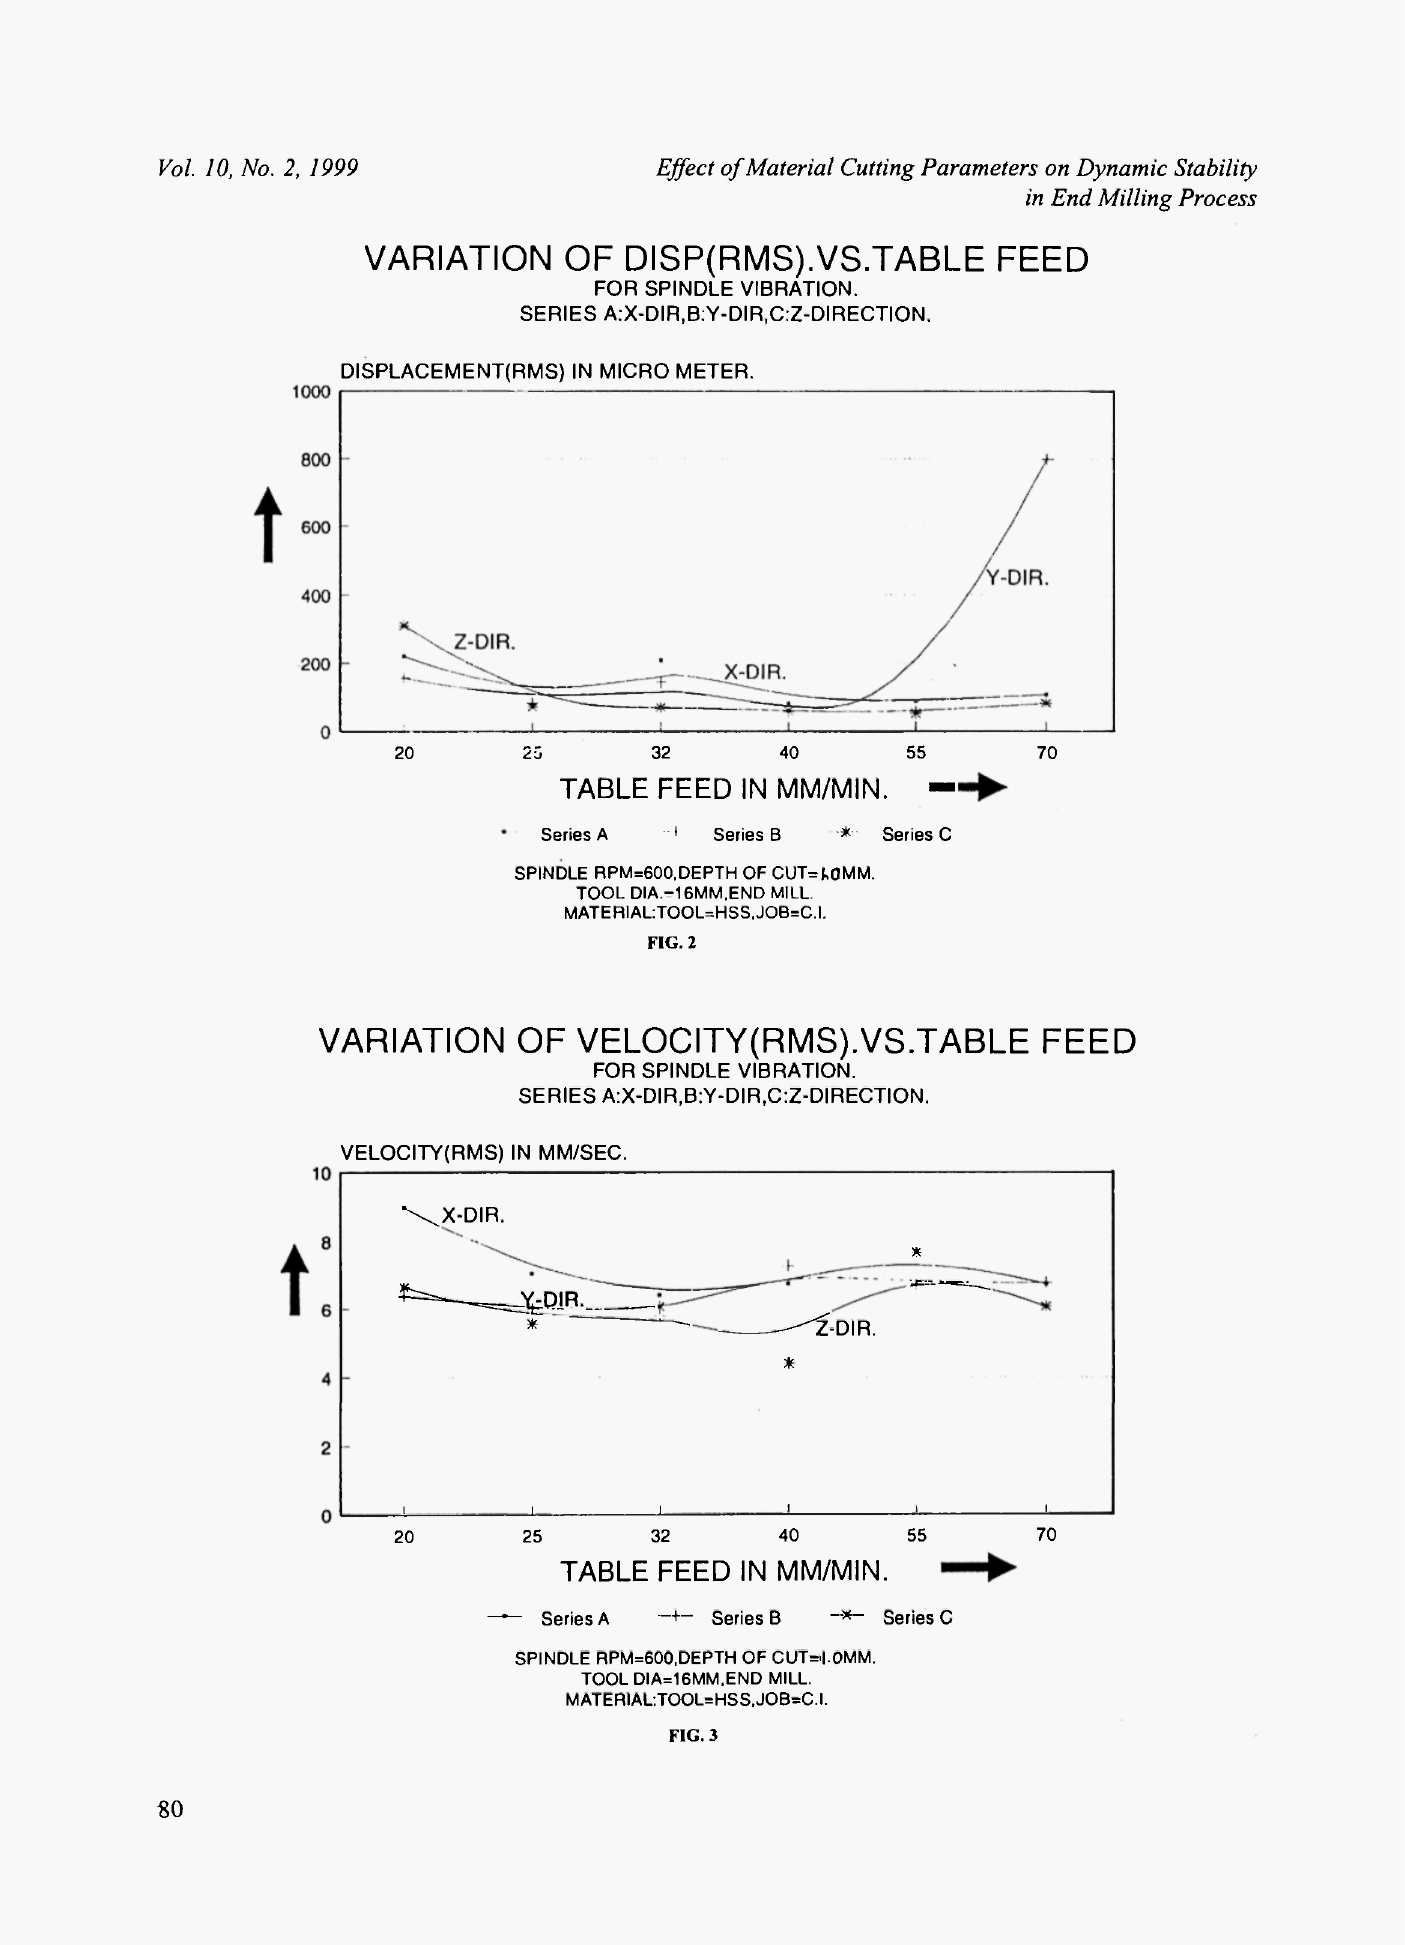
—— Series A —+- Series Β - *- Series C SPINDLE RPM=600,DEPTH OF CUT=|.OMM. TOOL DIA=16MM,END MILL.